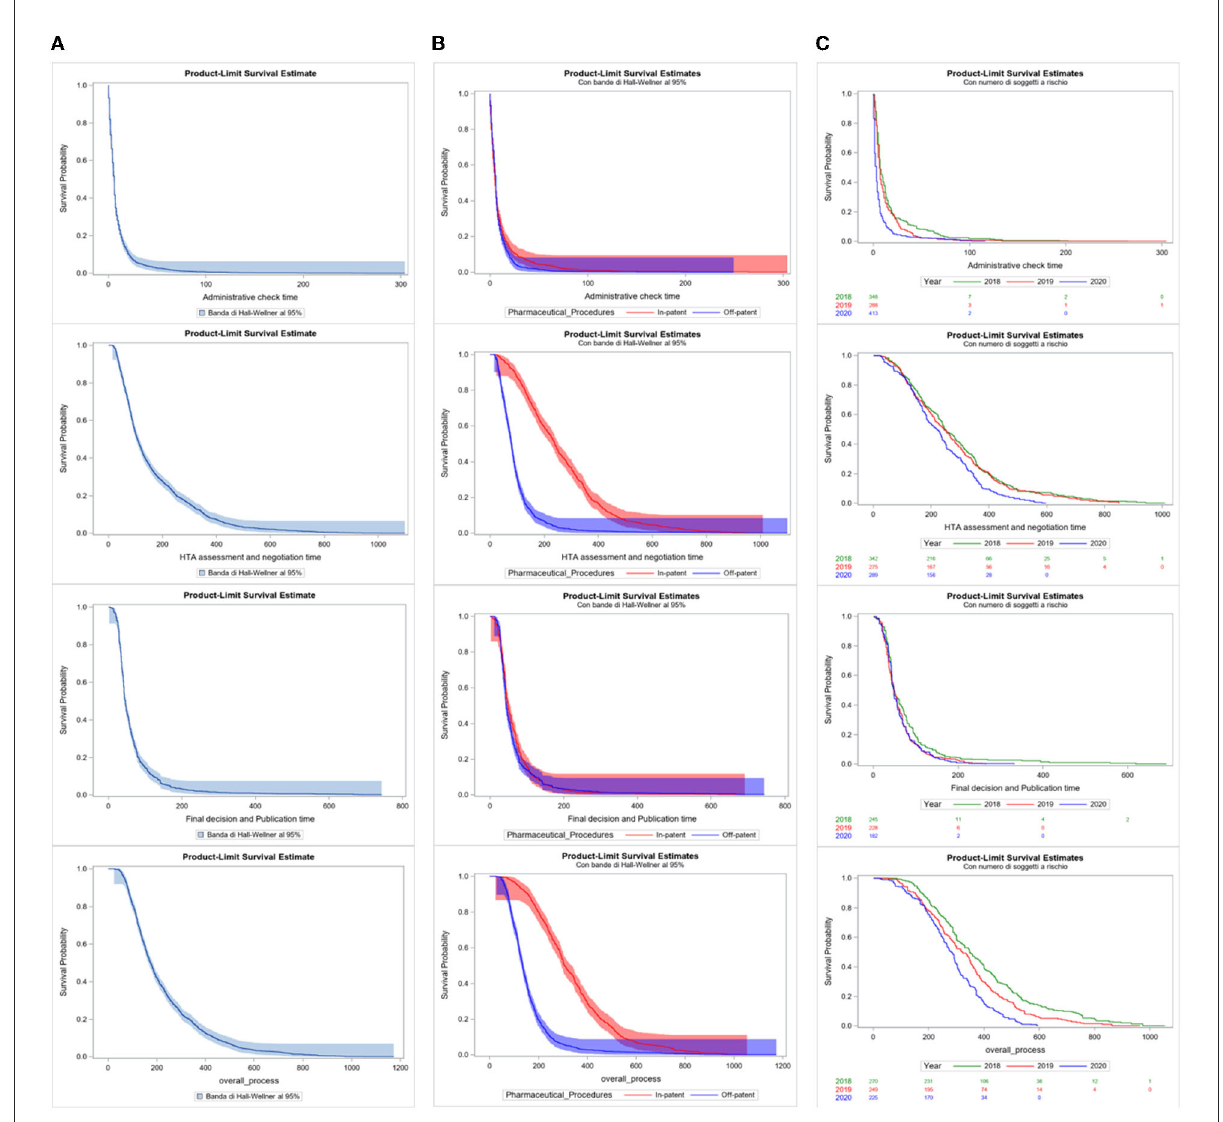
FIGURE5 (A–C) Kaplan–Meier curves of time days indicators by total, by pharmaceutical procedures, and per year.